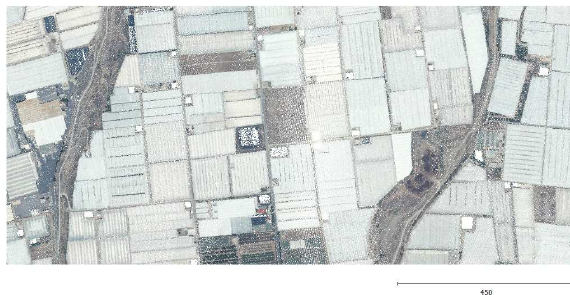
Figure 3. Study site presented as a coloured LiDAR point cloud. Note that some irrigation pools are shown in white (no